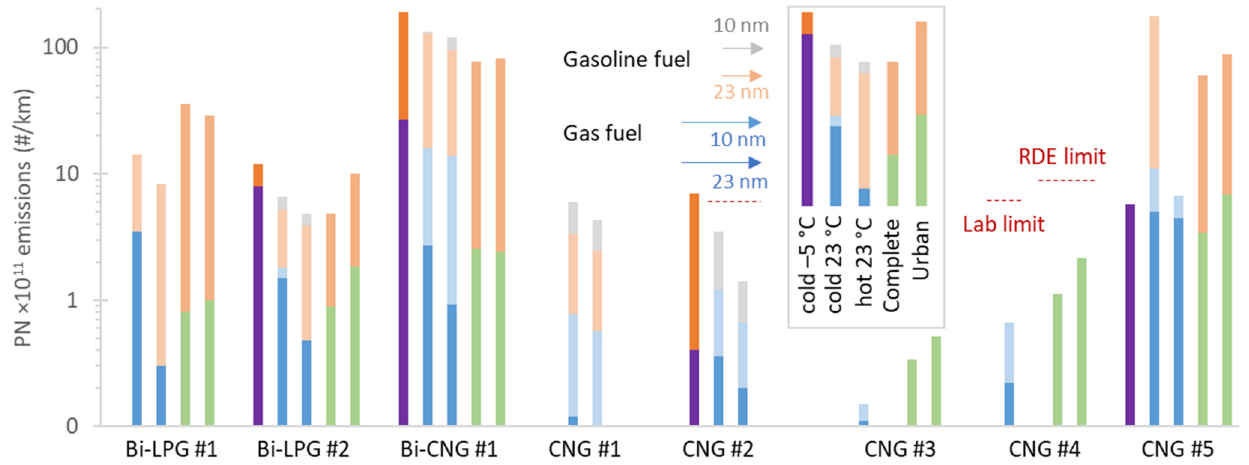
Figure 4. PN emissions. Dotted lines give the applicable Euro 6 emission limits in the laboratory (Lab) or on the road